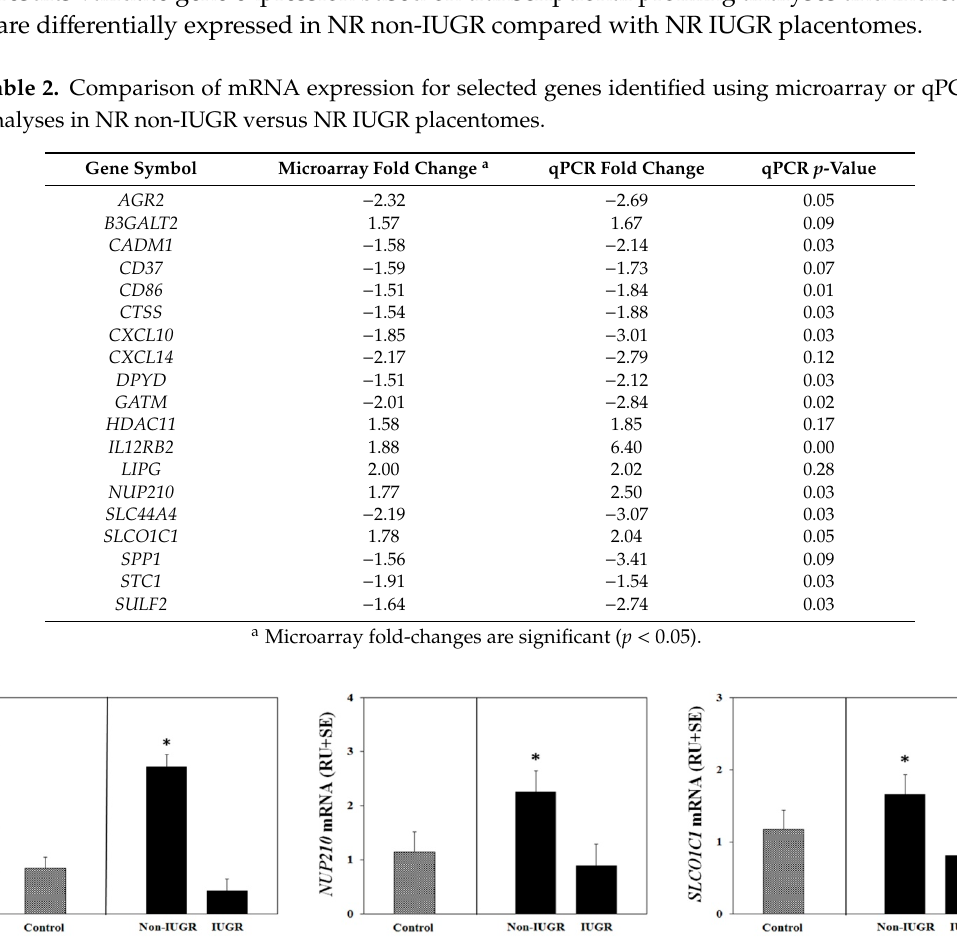
Figure 2. Select microarray-identified genes downregulated in NR non-IUGR placentomes were validated using qPCR. ( A ) GATM, SLC44A4, STC1 and SULF2 mRNA expression was greater ( p < 0.05) in NR IUGR compared to NR non-IUGR placentomes. ( B ) CADM1, CTSS, and DPYD mRNA expression was greater ( p < 0.05) in NR IUGR than NR non-IUGR placentomes. ( C ) CD86 and CXCL10 mRNA expression was greater ( p < 0.05) in NR IUGR than NR non-IUGR placentomes. Mean gene expression values from control fed ewes have been included for informative comparisons only and were not included in the statistical analysis. Legend: RU, relative units. * Indicates p < 0.05 between NR Non-IUGR and NR IUGR placentomes.